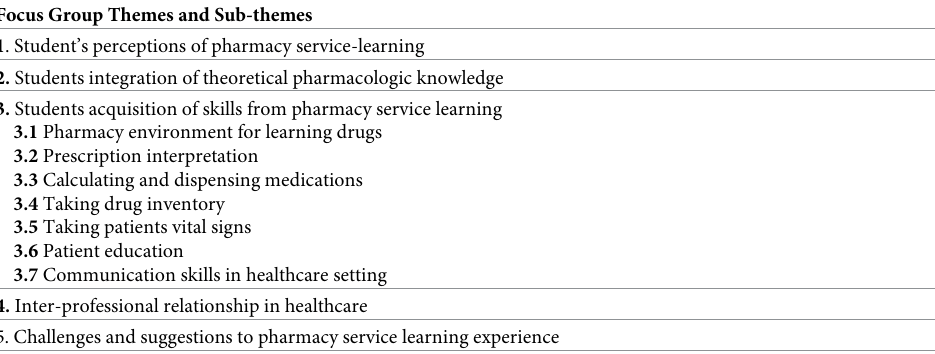
Table 1. Themes and sub-themes identified during analysis of focus